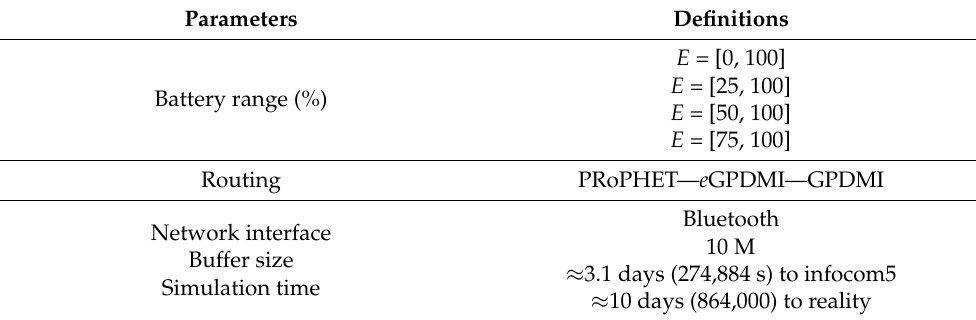
Table 6. Simulation